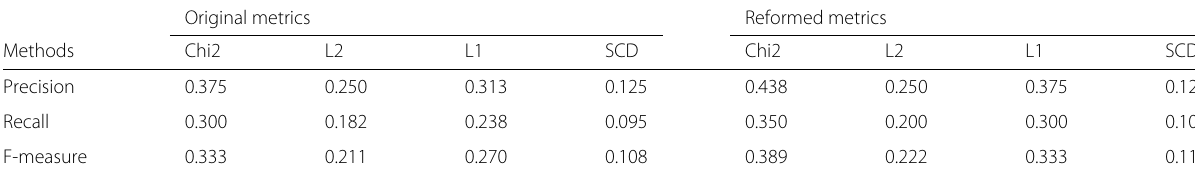
Table 2 Comparison of the reformed metrics in similarity face retrieval Original metrics